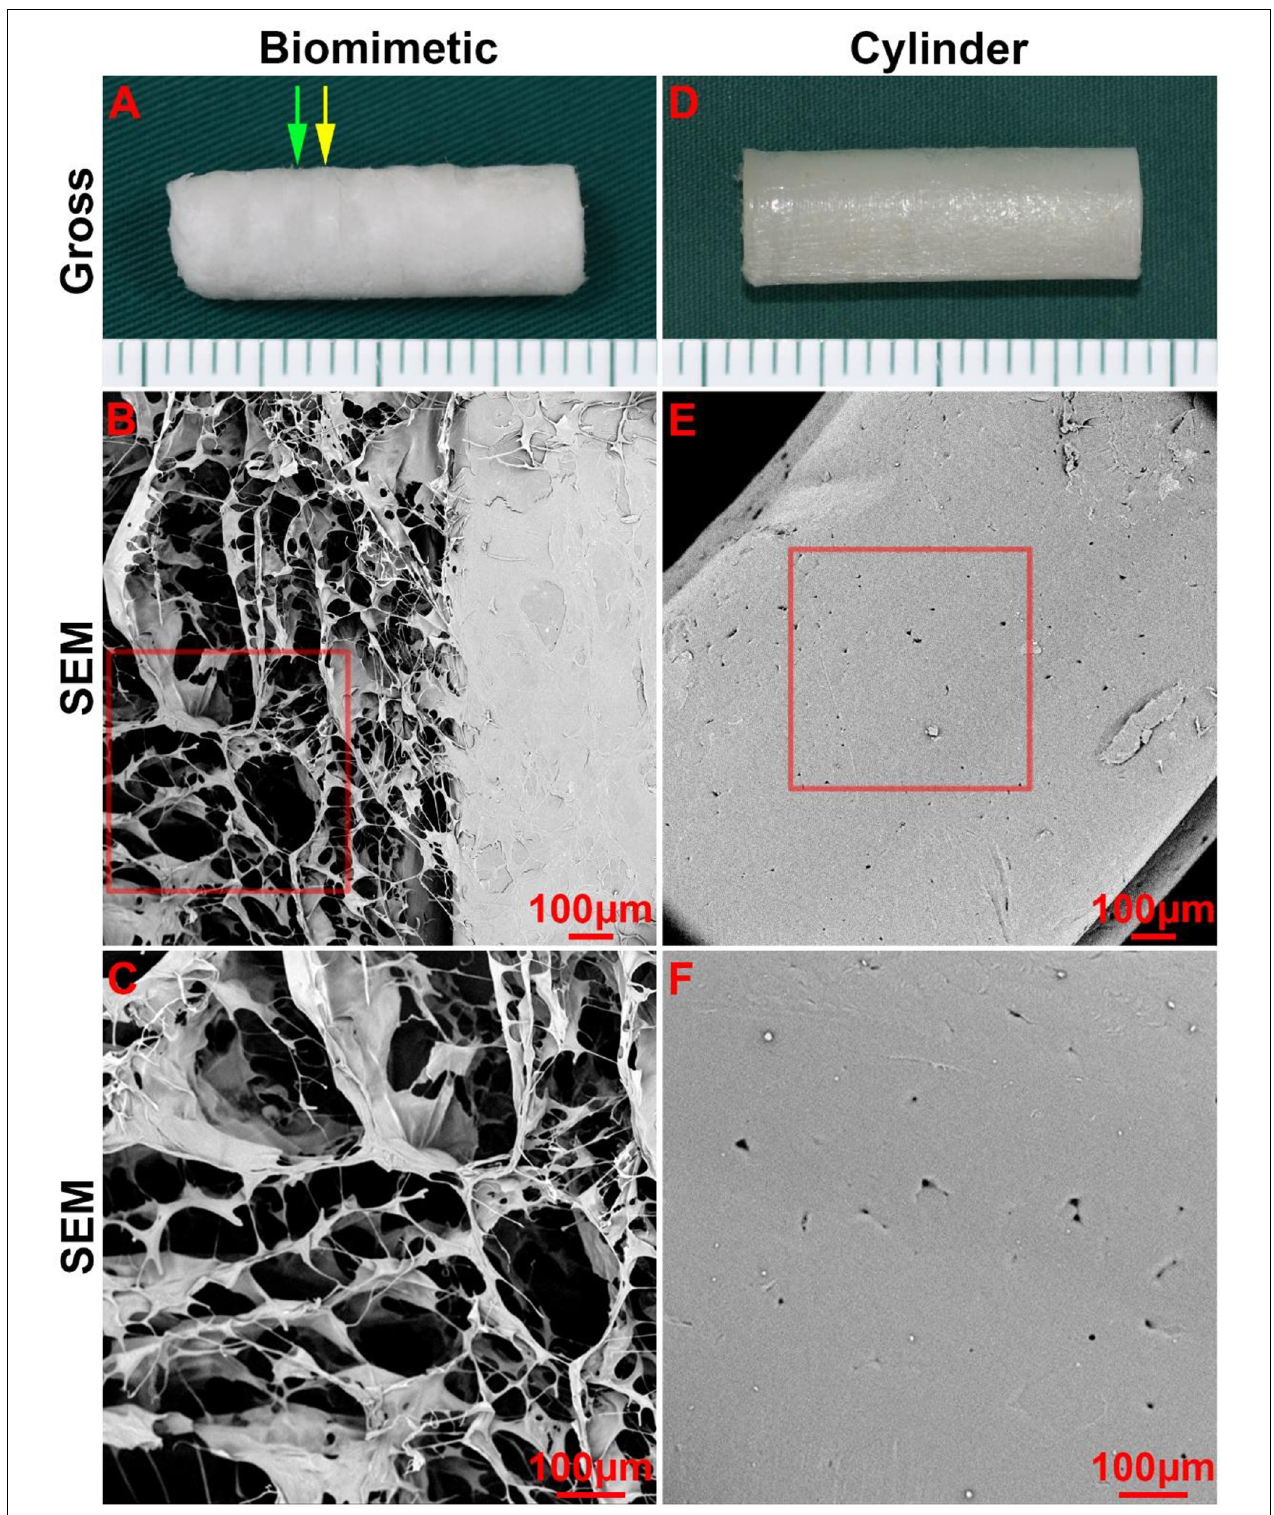
FIGURE 2 | Morphology of the biomimetic scaffold and cylindrical tube. Macro-morphology of the biomimetic scaffold (A) and cylindrical tube (B) . Micro-morphology of the biomimetic scaffold (B–C) and cylindrical tube (E–F) as observed by SEM. The green arrow indicates the collagen region, and the yellow arrow indicates the PCL